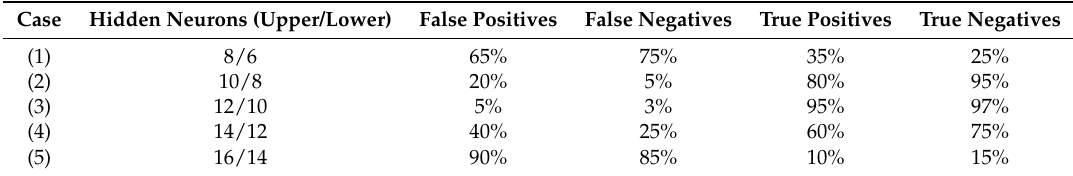
Table 2. Neural networks with different numbers of hidden